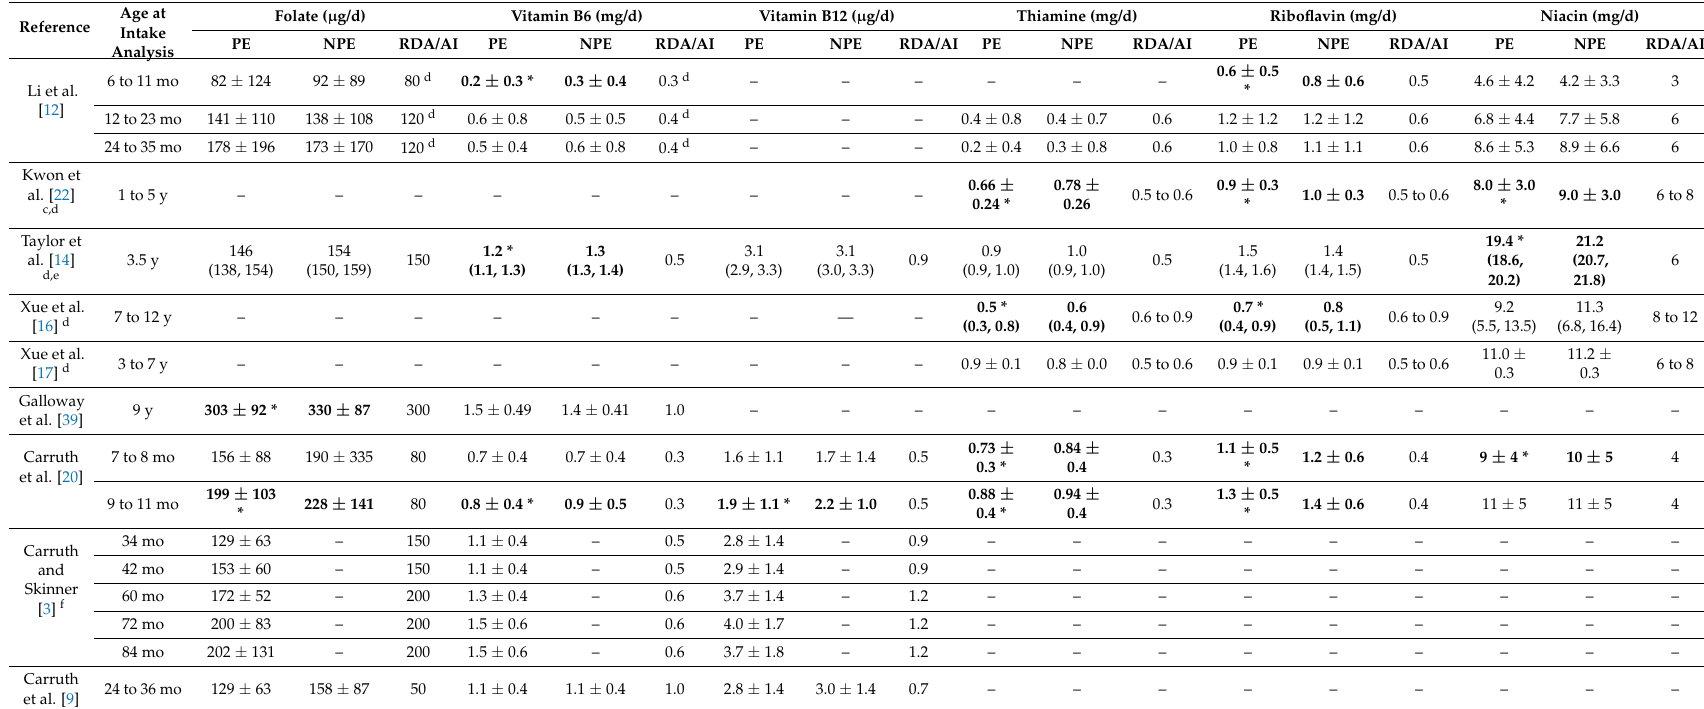
Table 7. Intakes of B Vitamins in PE and NPE a,b